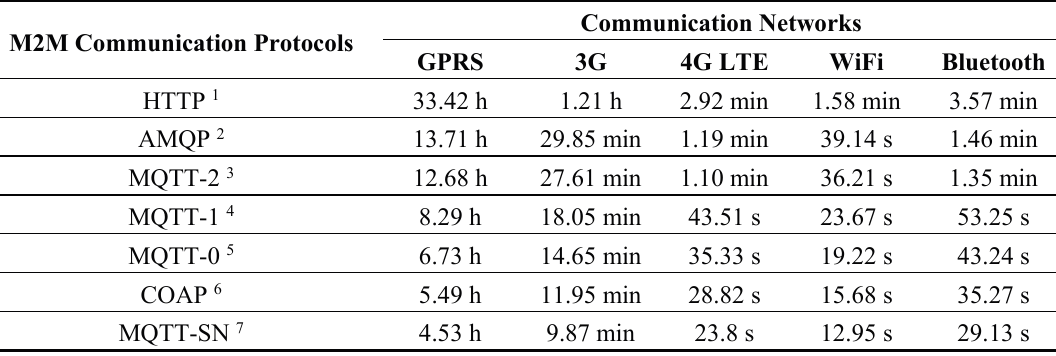
Table 7. Estimated transmission delays for all the collected heath data segments versus different communication networks and secure M2M communication